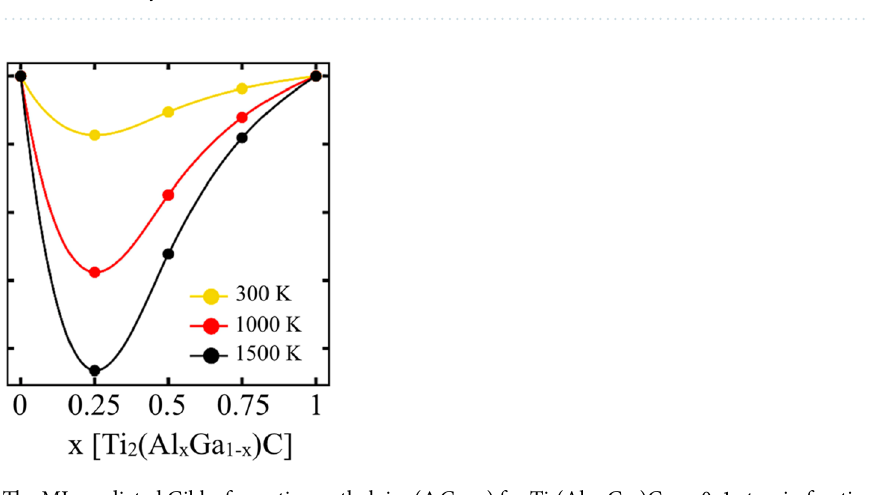
Figure 3. The ML predicted Gibbs formation enthalpies ( (cid:31) G form ) for Ti 2 (Al 1−x Ga x )C, x = 0, 1 atomic-fractions at 300 K, 1000 K, and 1500 K (see the (cid:31) G form in Table 1) with respect to Ti 2 GaC (x = 0) and Ti 2 AlC (x = 1).